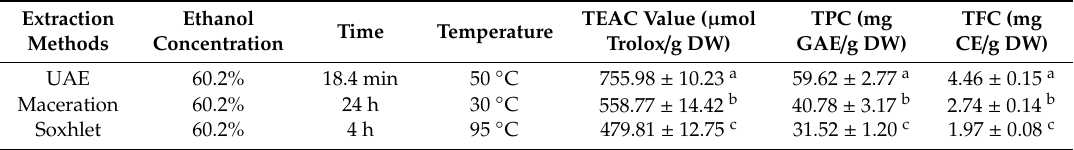
Table 4. Comparison between ultrasound-assisted extraction (UAE) and conventional extracting